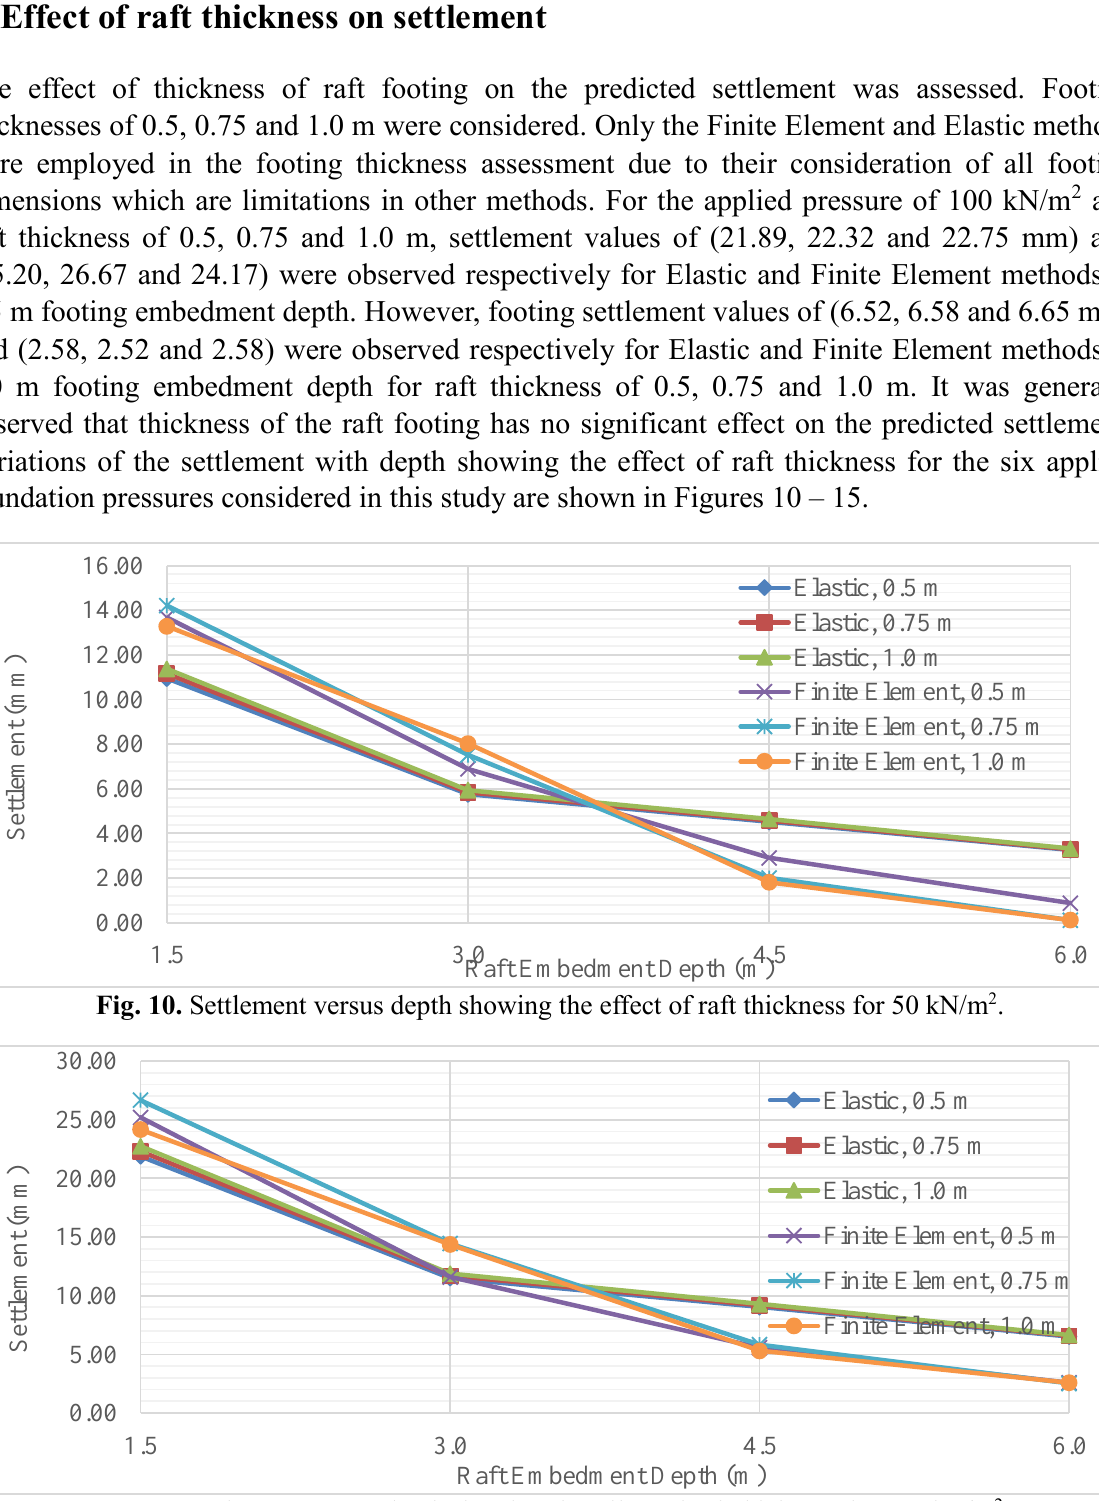
Fig. 11. Settlement versus depth showing the effect of raft thickness for 100 kN/m 2